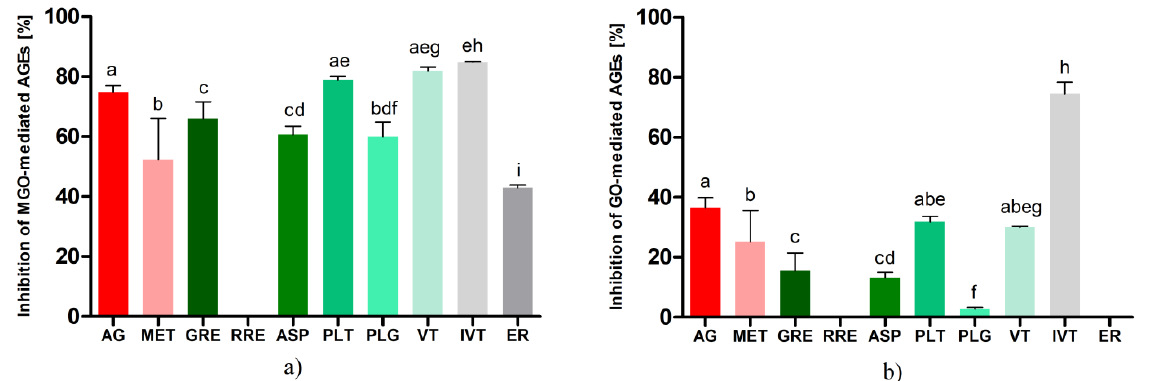
Figure 1. Antiglycation activity after seven days of incubation of bovine serum albumin with glycation agents (0.5 mM) and tested compound (1.5 mM) or hydroethanolic extracts (500 µ L, DER 1:100) expressed as % inhibition of: ( a ) MGO mediated-AGE formation, ( b ) GO-mediated AGE formation. Results are representative of three experiments performed in triplicate ± SD. Values not sharing a common letter are significantly different at p < 0.05 according to Tukey’s multiple comparisons test. Abbreviations: AG, aminoguanidine; MET, metformin; GRE, green rooibos extract; RRE, red rooibos extract; ASP, aspalathin; PLT, phloretin; PLG, phloroglucinol; VT, vitexin; IVT, isovitexin; ER, eriodictyol.